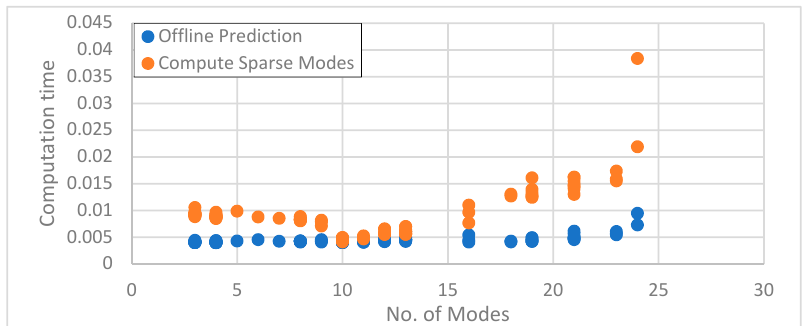
Figure 6. Computation time for sparse DMD modes and o ffl ine